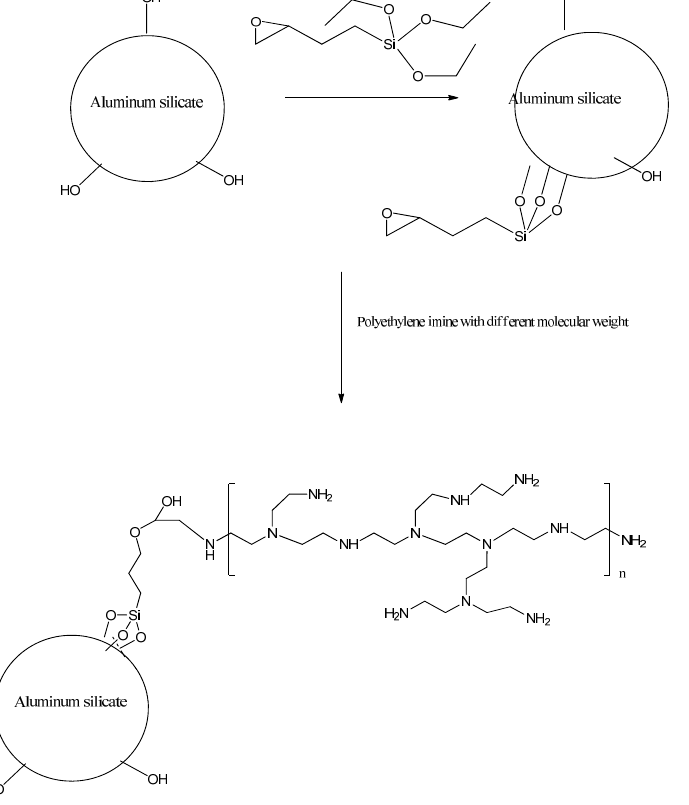
Figure 1. Scheme of surface modification of GM and BGM with organic compounds.